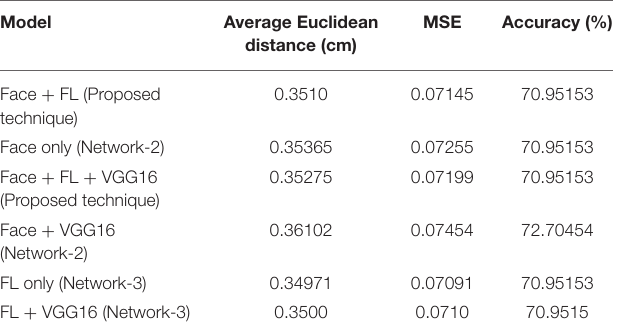
FIGURE 10 | Results for Face + FL + VGG16 on TabletGaze dataset.